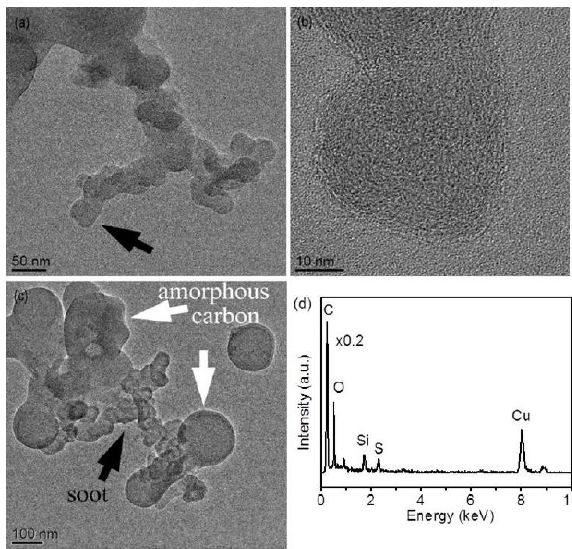
Figure 4. TEM image (a) of soot collected at 1500 m and its HRTEM image (b) from the arrowed area. (c) TEM image of soot (black arrow) mixed with amorphous carbonaceous spheres (white arrows). EDS (d) collected from the soot in image (a). The intensity of carbon peak is multiplied by factor of 0.2 for comparison with the weak signals from other elements.